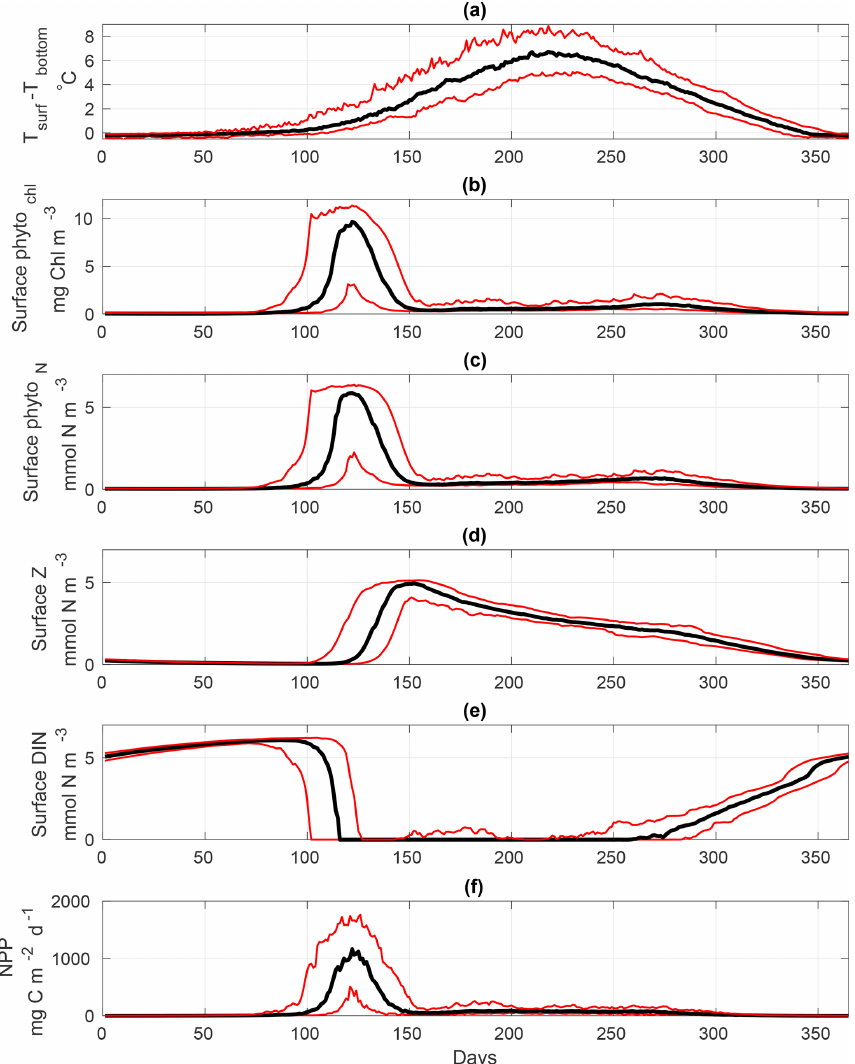
Figure 7. Annual representation of the median (black lines) calculated from 1965 to 2015 for the S2P3 v8.0 model calibrated for the CCS location and forced with all meteorological components (i.e. wind speed, cloud coverage, air temperature, and relative humidity). Red lines represent the annual lower and upper quantiles for each variable of the model (95% distribution of the data) over 1965–2015. (a) Surface temperature minus bottom temperature ( ◦ C), (b) surface chlorophyll a (mgChlm − 3 ), (c) surface zooplankton biomass (mmolNm − 3 ), (d) surface DIN (mmolNm − 3 ), and (e) net primary production (NPP) (mgCm − 2 d − 1